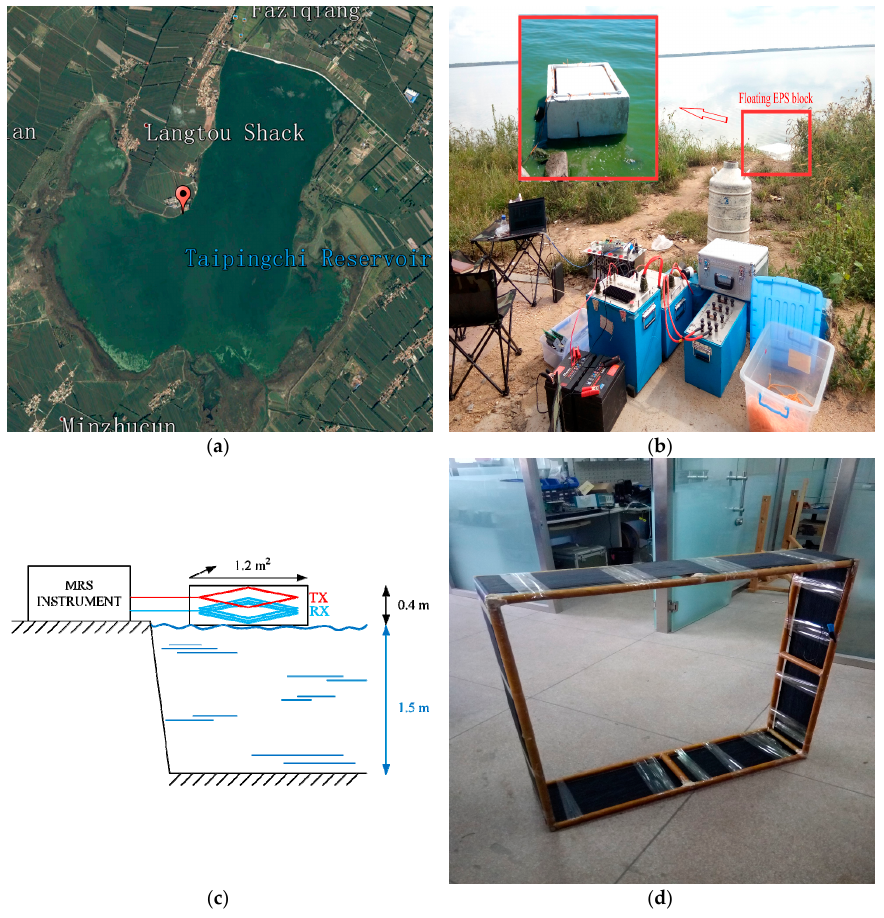
Figure 11. Field location and scenario. ( a ) Satellite map; ( b ) floating coil sensor and instrument; ( c ) schematic diagram for measurement; ( d ) rigid 1 m coil.